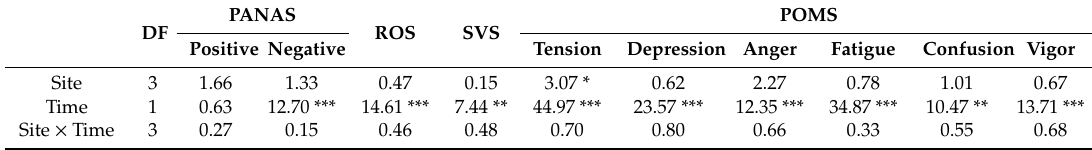
Table3. Resultsofmixed-modelANOVAforpsychologicalvariables, degreesoffreedomandFstatistics. DF